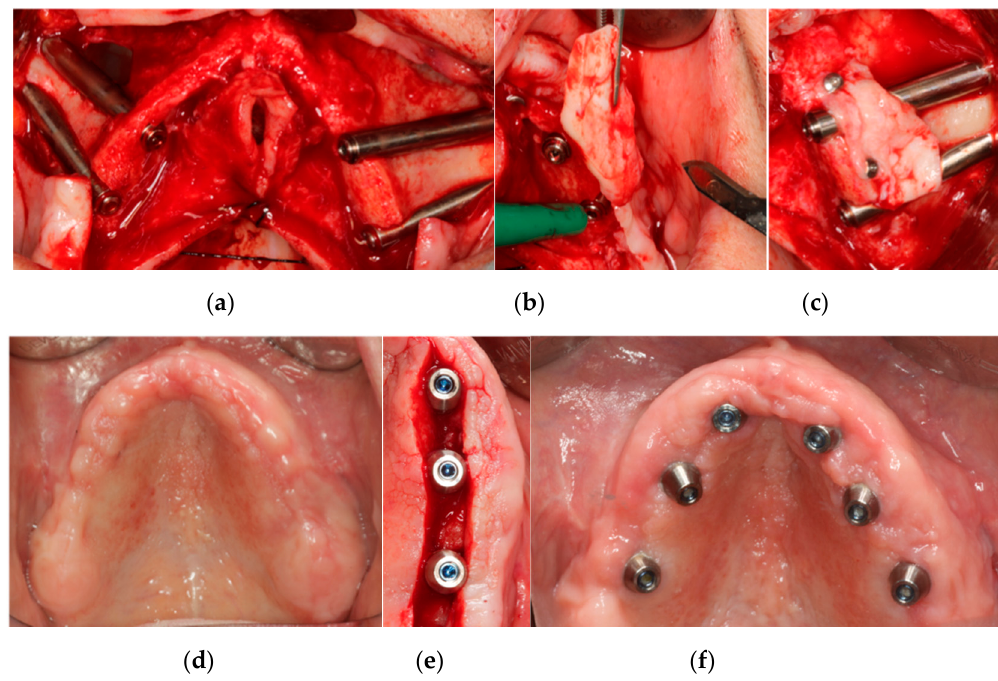
Figure 3. ( a ) Zygoma Quad system with buccal dehiscences seen in both quadrants (Smooth IPX-Tilted System®, Galimplant S.L, Sarria, Galicia, Spain). ( b ) A free connective soft tissue graft is collected from the palatal flap. ( c ) Soft tissue graft is repositioned with two surgical pins around the neck of the zygomatic implants. ( d ) Soft tissue healing at one month after the operation. ( e ) The gained soft tissue volume is seen in second stage surgery. ( f ) Soft tissue healing at three weeks after second stage surgery. The buccal mucosa is thick and keratinized.